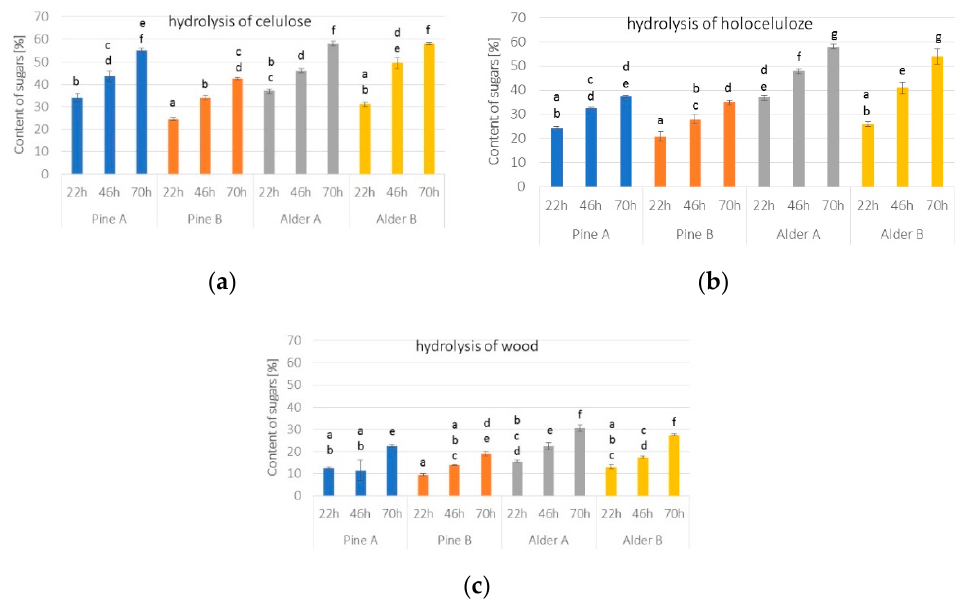
Figure 2. Total sugar yield from enzymatic hydrolysis of: ( a ) Kürschner–Hoffer cel-lulose, ( b ) holo- cellulose, and ( c ) wood. Letters from a to f in the graph correspond to the groups by Tukey test ( α = 0.05).